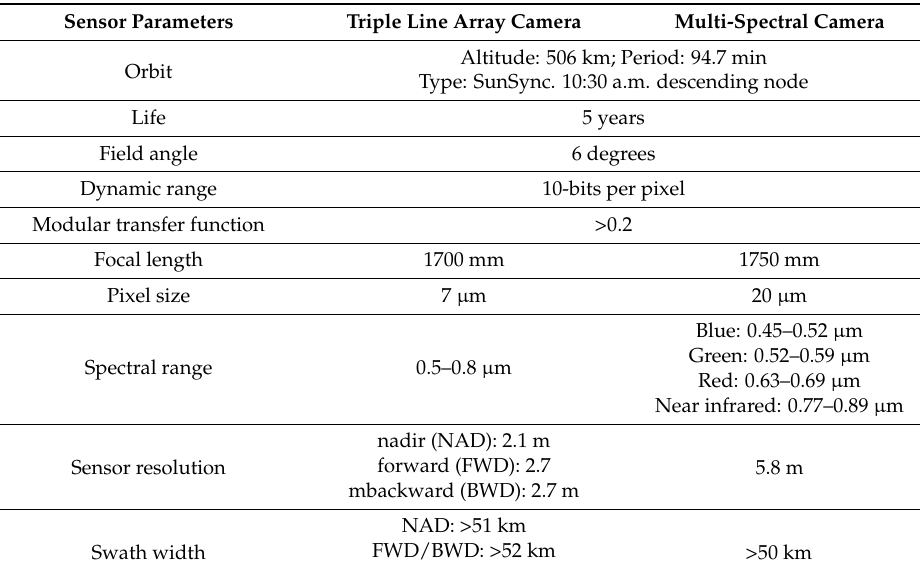
Figure 1. Optical butting system of each sensor—nadir (NAD), forward (FWD), backward (BWD)—in the triple linear array camera (TLC) of ZY3-02. Table 1. Design and specification information for the ZY3-02